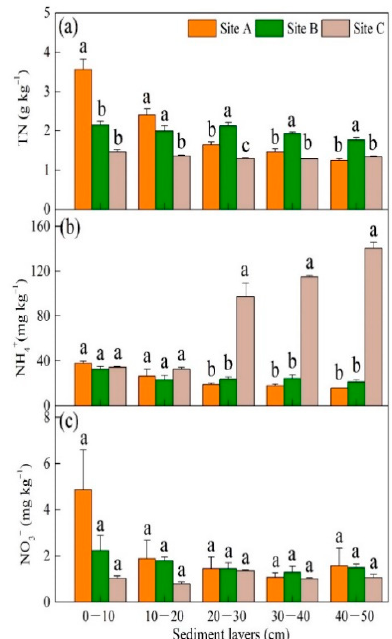
Figure 2. Sedimentary concentrations along the inundation gradient for ( a ) total nitrogen (TN), ( b ) ammonium N (NH 4 + ), and ( c ) nitrate N (NO 3 − ) concentrations along the hydrological gradient (mean ± SE). Different letters above bars denote significant difference among sites ( p < 0.05). Sites A, B, and C refer to the high tidal flat, interaction zone between high and middle tidal flats, and middle tidal flat, respectively.